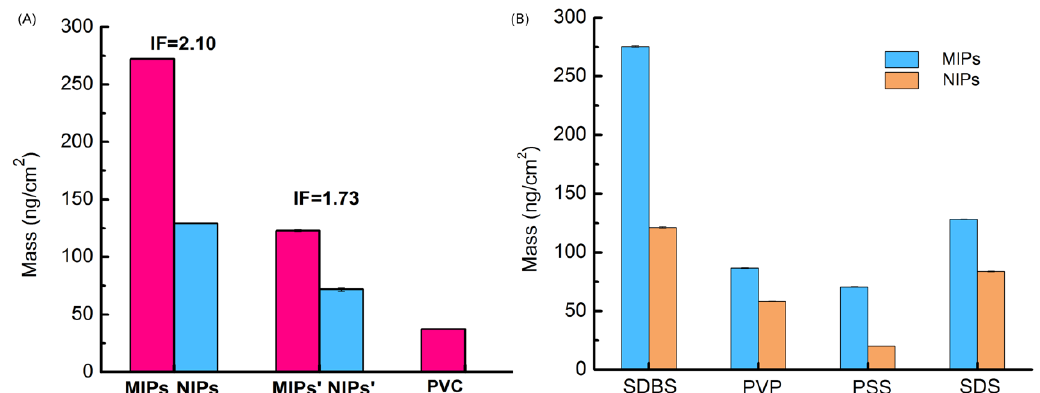
Figure 4. Methylene blue adsorption capacities for the quartz crystal microbalance with dissipation monitoring sensors prepared using different materials. ( A ) Sensors prepared using molecularly imprinted polymers (MIPs) and non-imprinted polymers (NIPs) prepared with and without surfactant and with pure polyvinyl chloride (PVC). ( B ) Sensors prepared using MIPs and NIPs fabricated using various surfactants (sodium dodecyl benzene sulfonate (SDBS), polyvinyl pyrrolidone (PVP), polyvinyl chloride (PVC), poly(sodium-p-styrene sulfonate) (PSS), and sodium dodecyl sulfate (SDS)). IF is the imprinted factor. Mean value ± standard deviation, n = 3.